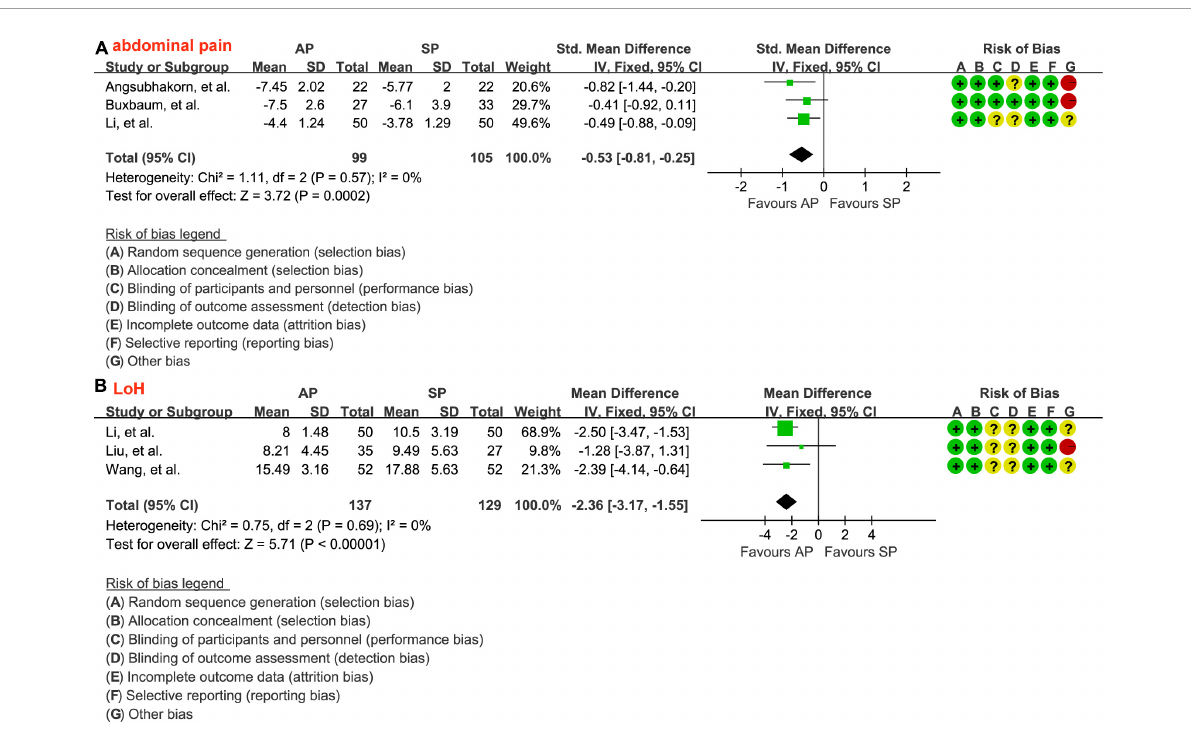
FIGURE5 Forest plot of the relief of epigastric abdominal pain (A) and the LoH (B) . LoH, length of hospital stay; AP, aggressive hydration protocol; SP, standard hydration protocol; SD, standard deviation; CI, confidence interval; IV, inverse